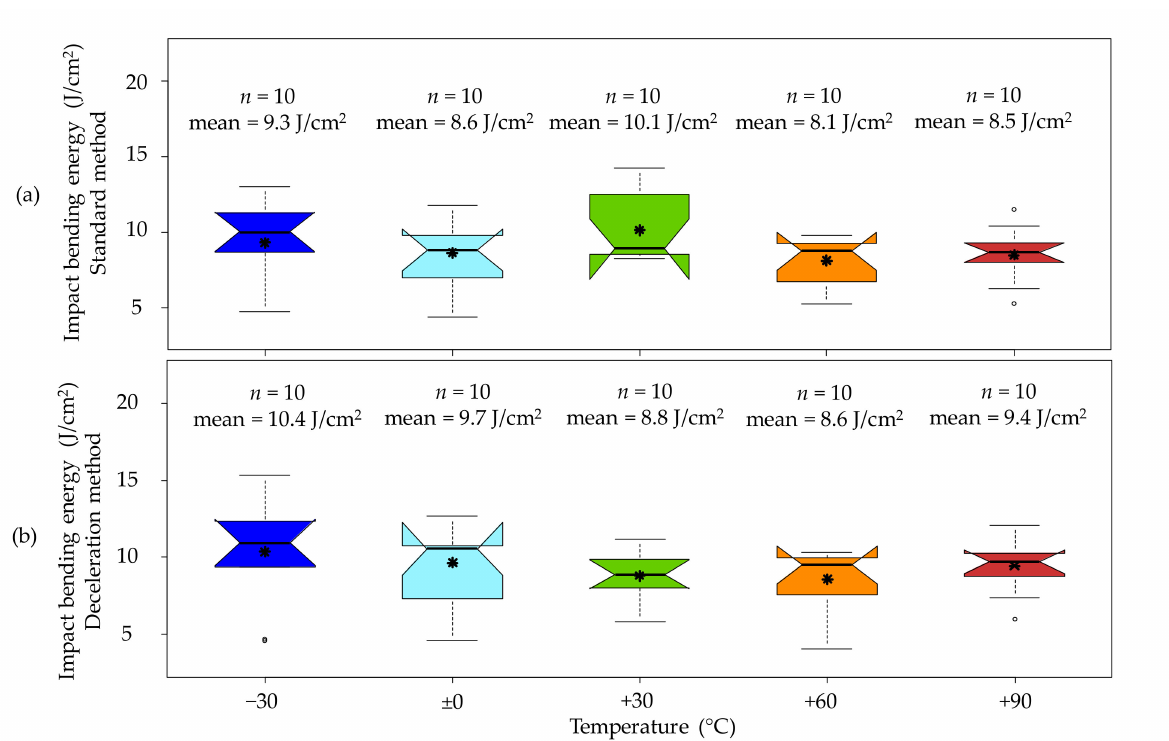
Figure 4. Boxplots of the impact bending energy of birch by temperature level, with the standard method ( a ) and with the deceleration method ( b ). * An interpretation aid concerning the boxplots can be found in Appendix A, Figure